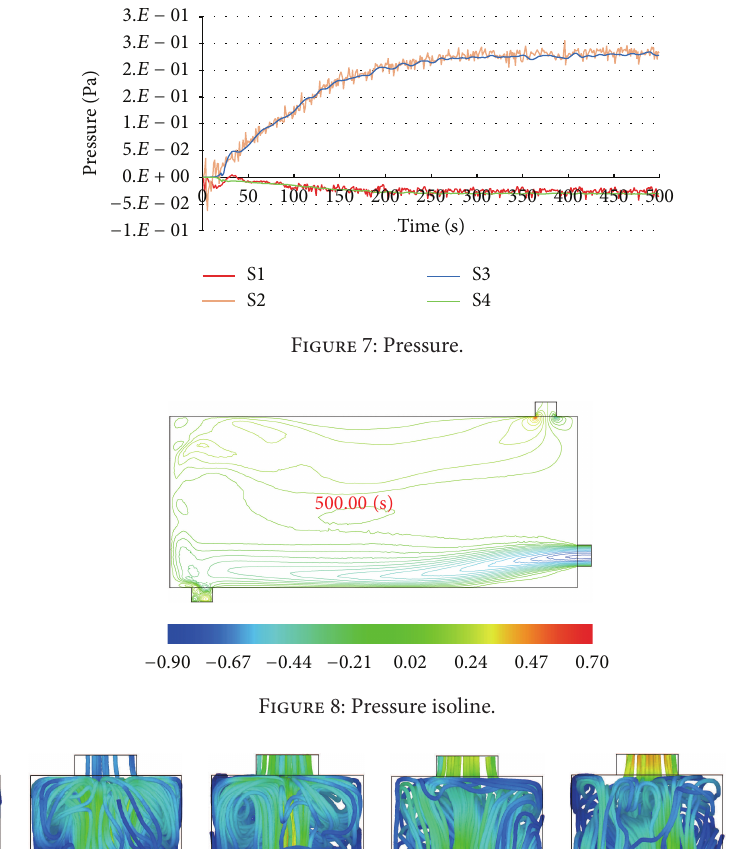
Figure 8: Pressure isoline.